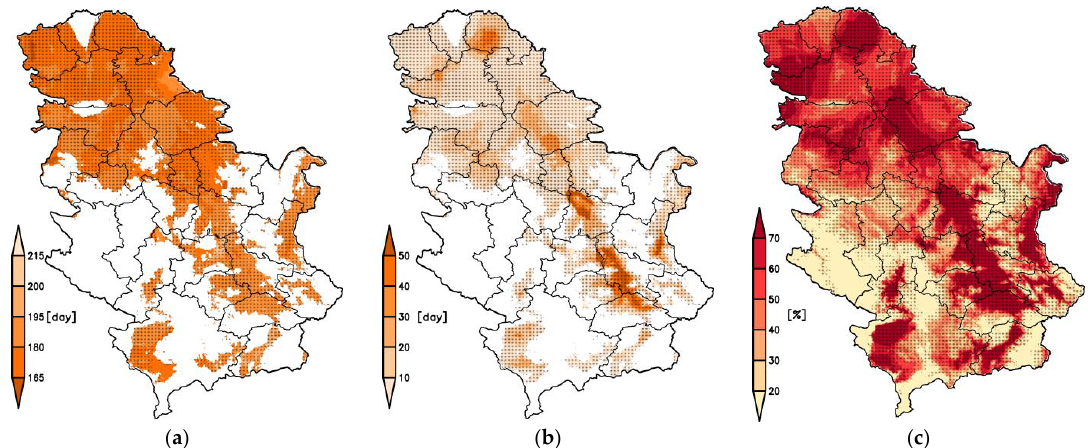
Figure 7. Mean date of the first occurrence of at least two consecutive days with Tx > 35 °C ( a ) and mean length of the period in which such events occurred, ( b ) for the period 1998 – 2017. Black dots mark areas where the change between the periods 1998 – 2017 and 1961 – 1990 is statistically signifi- cant. Data are given only for points in which such events occurred in more than half of the years of the period. Frequency of years in which at least two consecutive days with Tx > 35 °C occurred during summer ( c ) in the period 1998 – 2017. Black dots mark areas where the frequency has in- creased more than 10% between the periods 1998 – 2017 and 1961 – 1990.